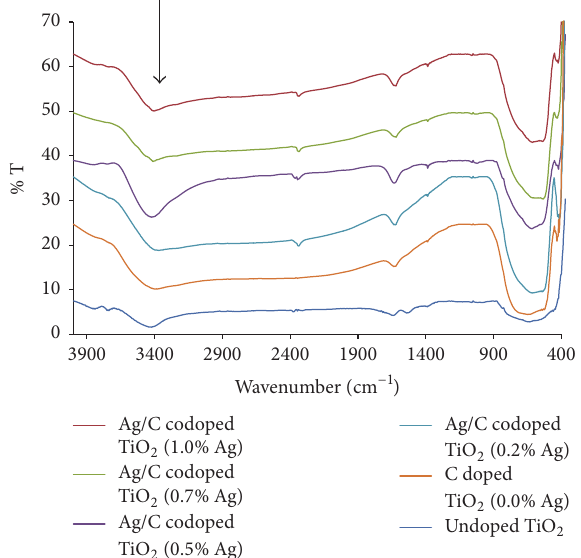
Figure 2: XRD patterns of undoped TiO 2 and Ag/C codoped TiO 2 photocatalyst powders with different contents of Ag prepared by a solo-gel